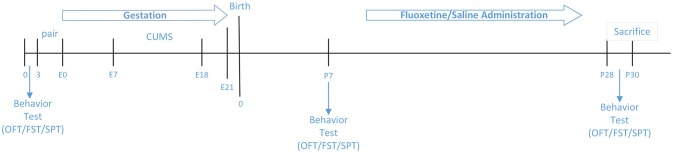
Couse of the study.